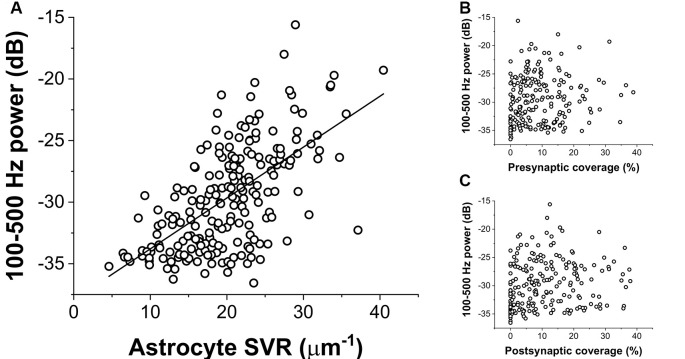
Correlation of the power of astrocytic Ca2+ oscillations (100–500 Hz) with geometric characteristics of the astrocyte processes. (A) Ca2+ oscillation is more pronounced in thin astrocytic processes characterized by a high SVR. The black line shows linear regression fitted to the data (R2 = 0.38). (B,C) Astrocytic Ca2+ oscillation shows no correlation with the extent of pre-or postsynaptic coverage by astrocytes.